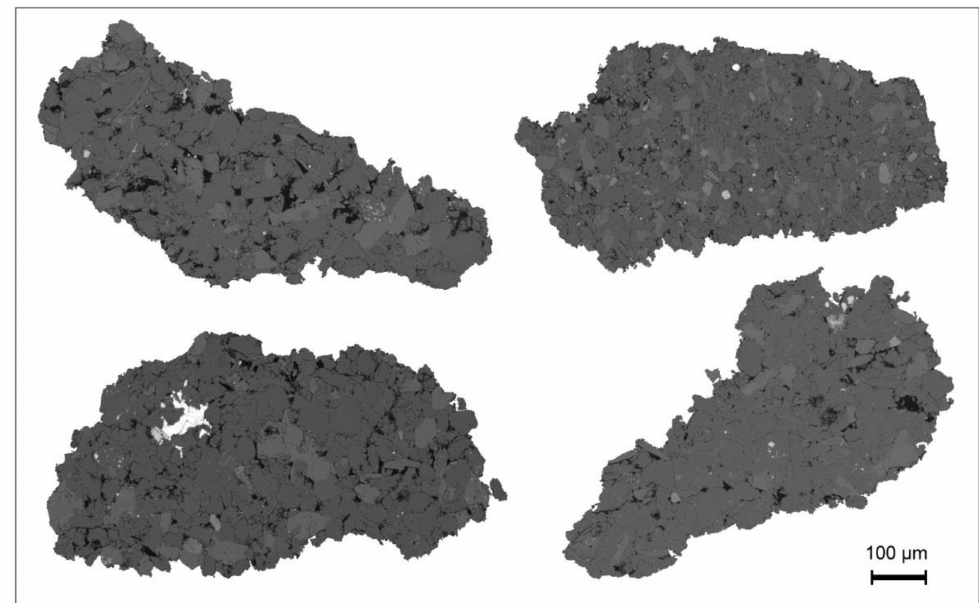
Figure 12. SEM-BS images of rock chips classified as porous siltstones. Note the contrast between the visual porosity (dark spots) among the four rock